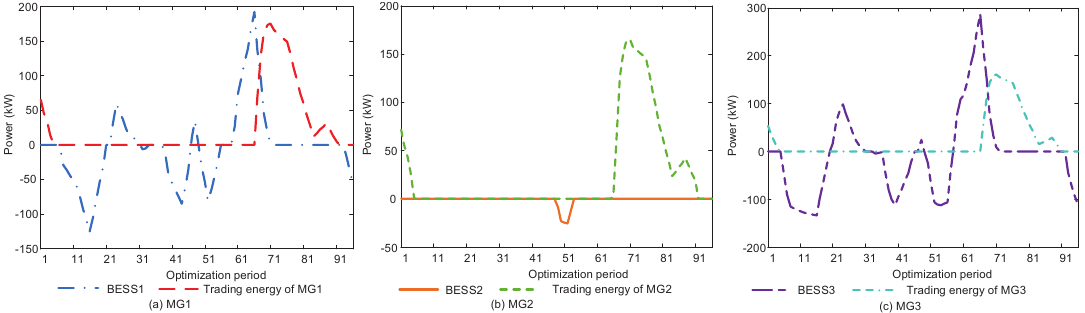
Figure 15. Scheduling results of BESS and purchasing power based on ADMM on Day 2 of Scenario 1 (( a ) MG1; ( b ) MG2; ( c )